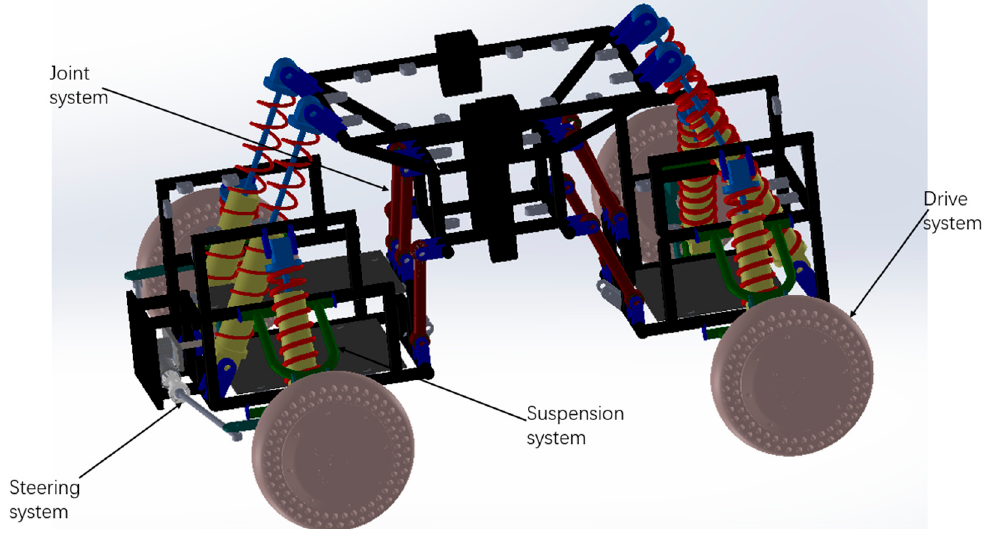
Figure 1. Vehicle structure.